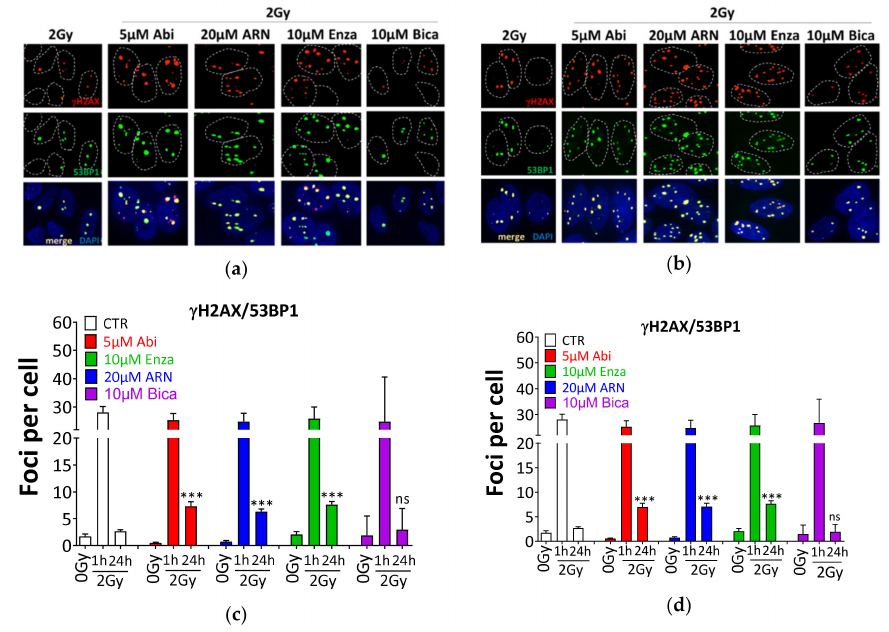
Figure 7. Second generation ADT inhibits the repair of ionizing radiation induced double strand